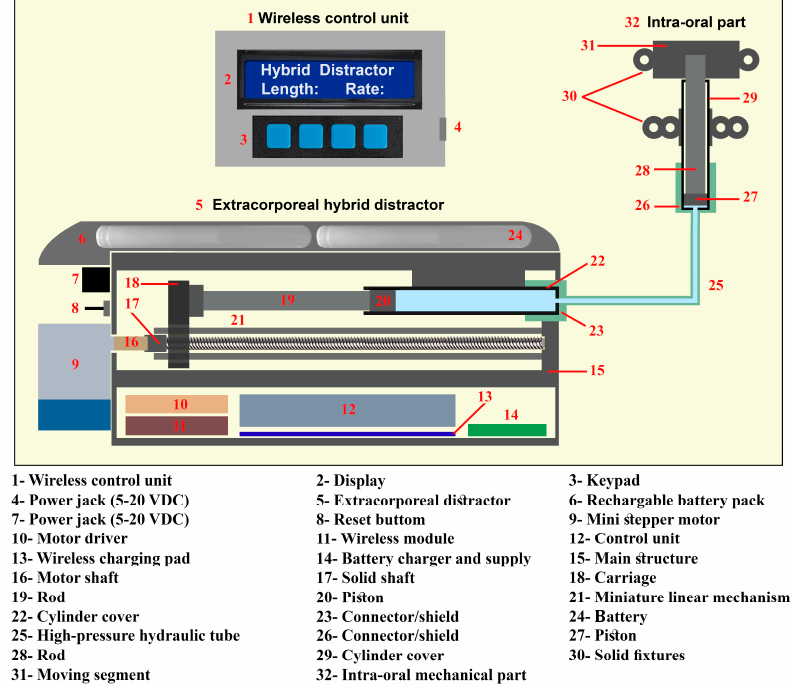
Figure 4. The schematic design of the hybrid